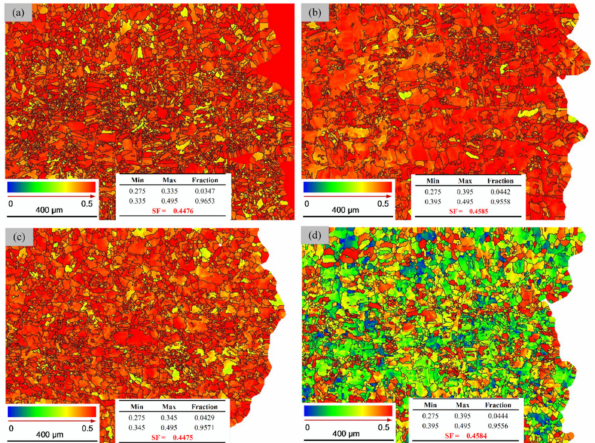
Figure 10. Schmid factor distribution at different volumetric energy densities VED: ( a ) 37.5 J/mm 3 ; ( b ) 62.5 J/mm 3 ; ( c ) 81.6 J/mm 3 ; ( d ) 93.7 J/mm 3